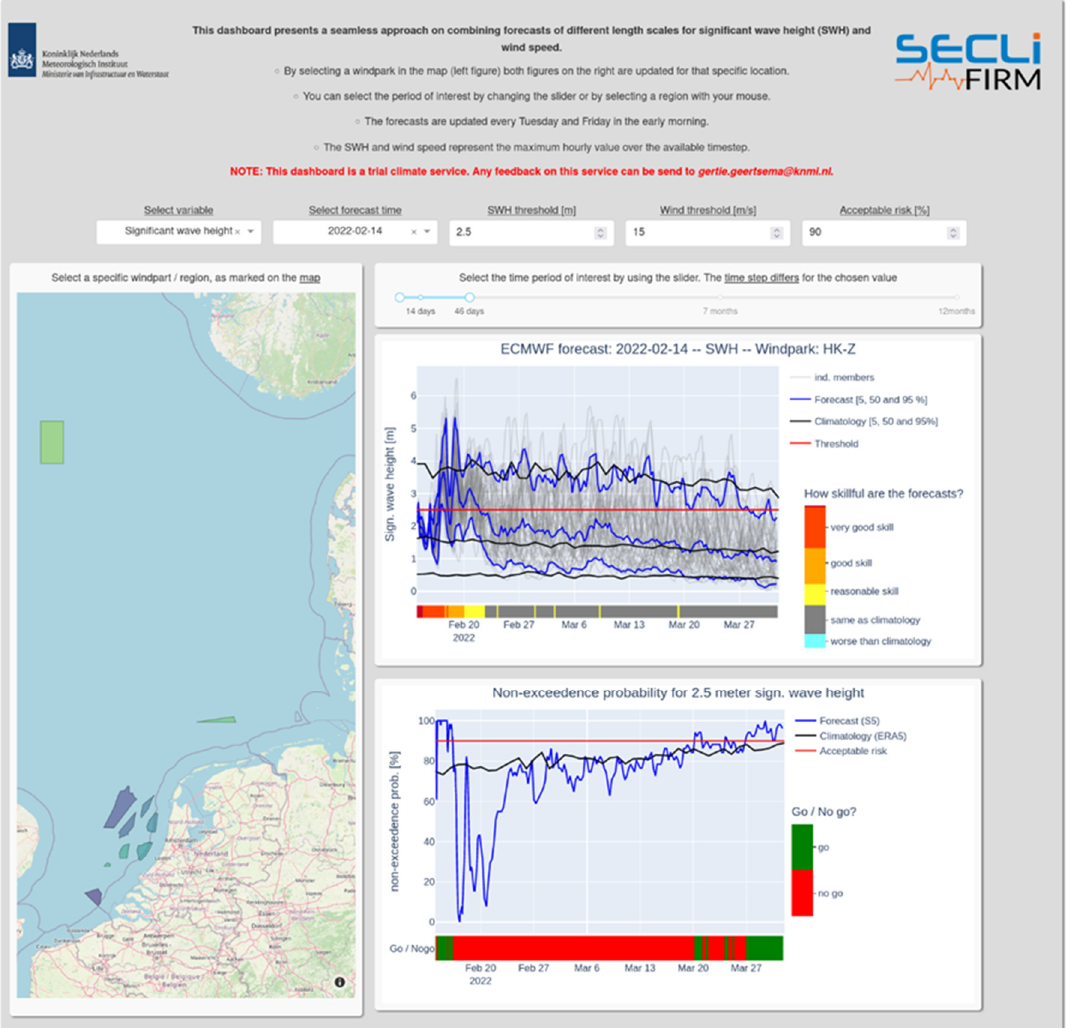
Figure 4. Screenshot of the interactive dashboard to disseminate seamless forecasts of significant wave height and wind speed for CS6. The user can select different thresholds and risks profiles to transform the probabilistic forecast to a go/no go answer.